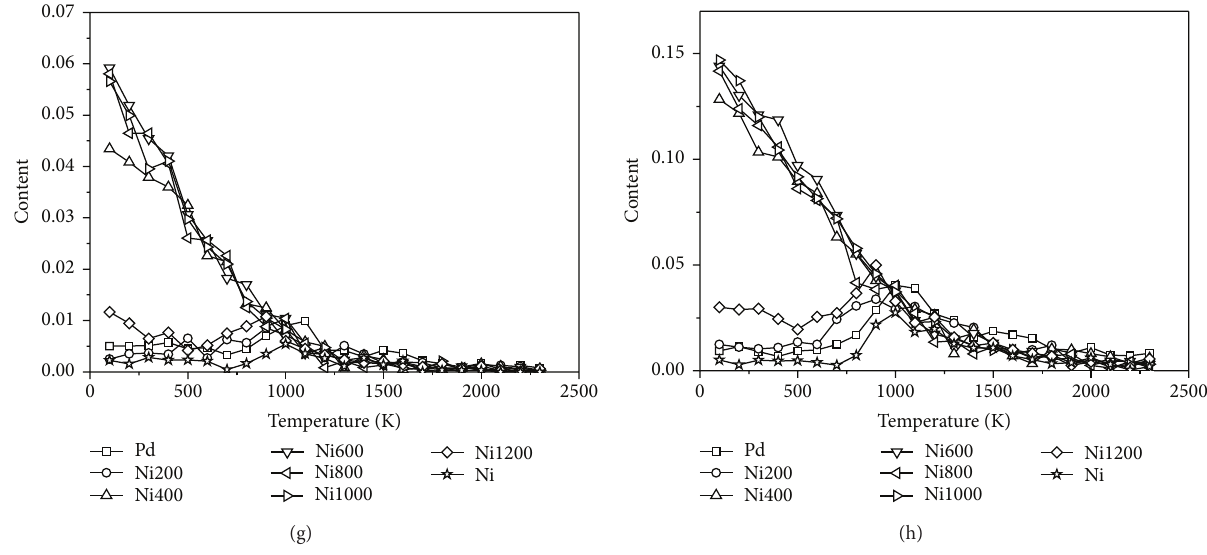
Figure 3: Relative amount of various atomic-bonded pairs includes (a) 1201, (b) 1311, (c) 1321, (d) 1421, (e) 1422, (f) 1551, (g) 1541, and (h) 1431 in Pd-Ni clusters at different temperatures during